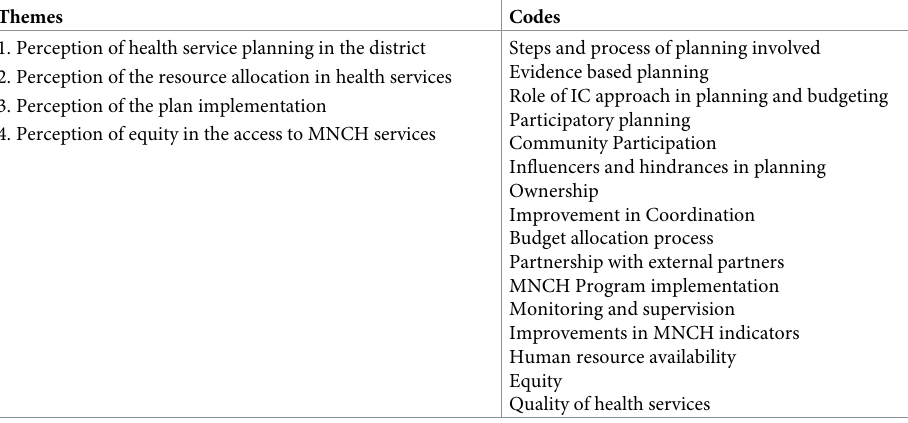
Table 2. Themes and categories for data